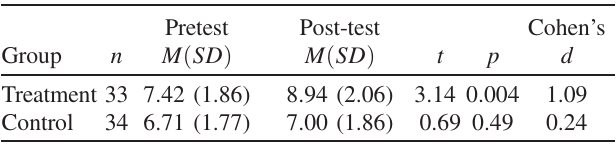
TABLE II. Results of the paired-sample t tests for the Optics Conceptual Test.